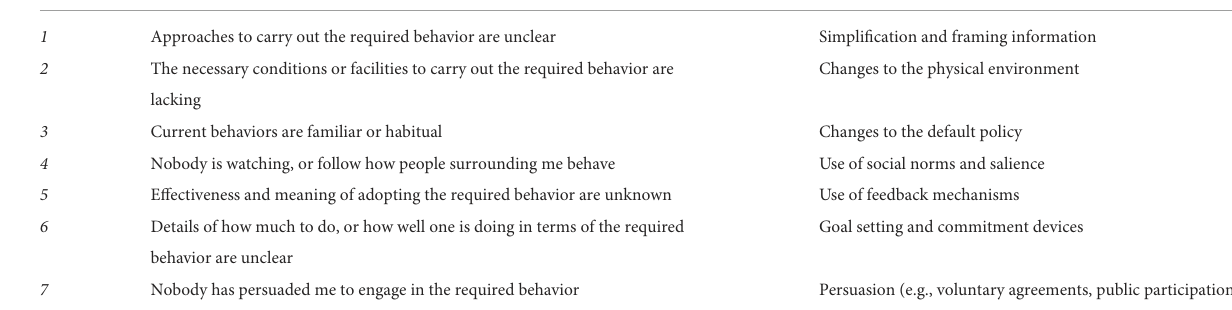
TABLE 3 Barriers derived from behavioral intervention measure